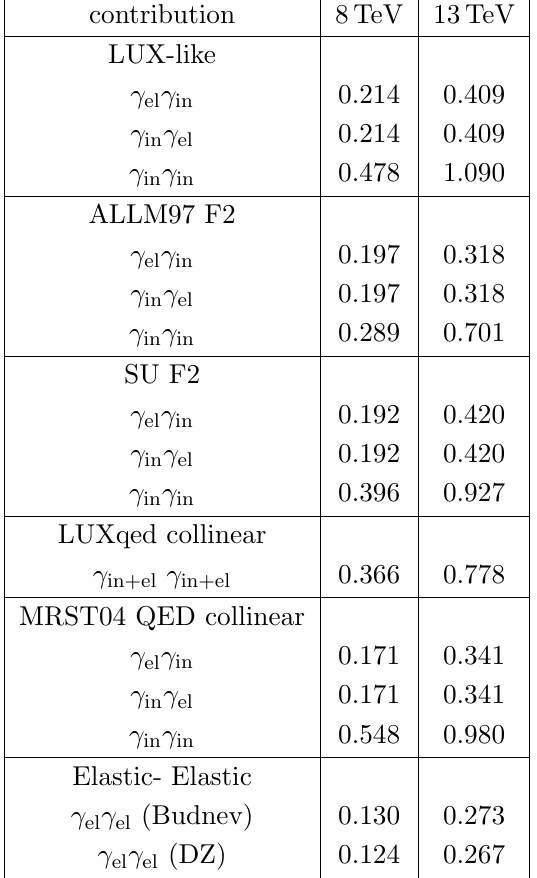
Table 1 . Cross sections (in pb ) for di(cid:11)erent contributions and di(cid:11)erent F2 structure functions: LUX, ALLM97 and SU, compared to the relevant collinear distributions with MRST04 QED and LUXqed distributions. The elastic-elastic contributions were obtained using (cid:13)uxes from refs. [1,